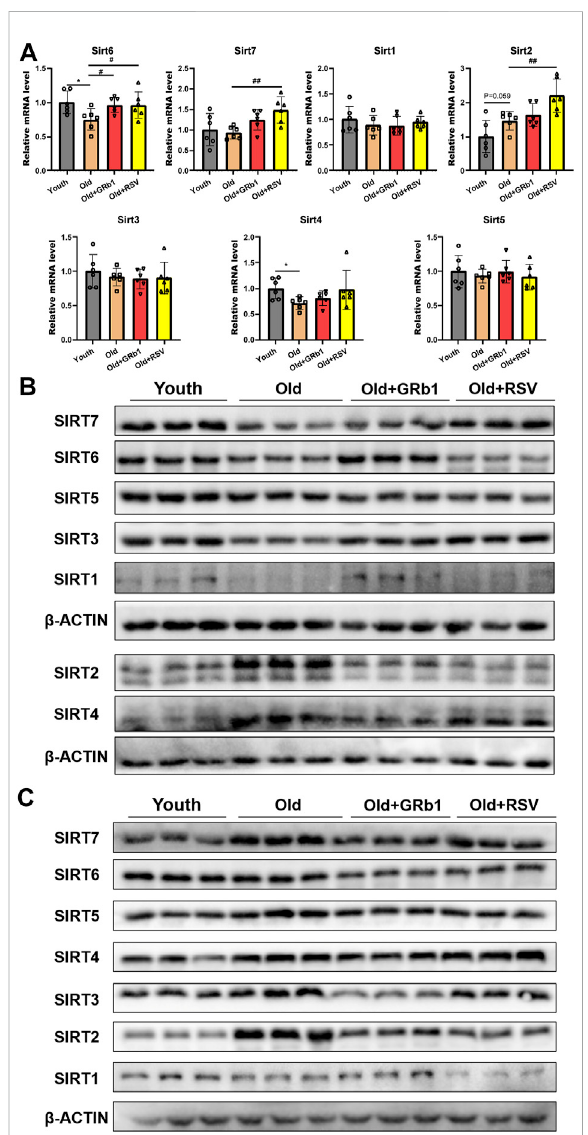
FIGURE 4 GRb1 improved the expression of Sirtuins in the intestines of old mice. (A) Relative mRNA expression levels of Sirt 1-7 in the jejunum. (B,C) Images of Western blot bands of SIRT 1-7 in the (C) jejunum and (D) colon. * p < 0.05, compared with the Youth group; # p < 0.05, ## p < 0.01, compared with the Old